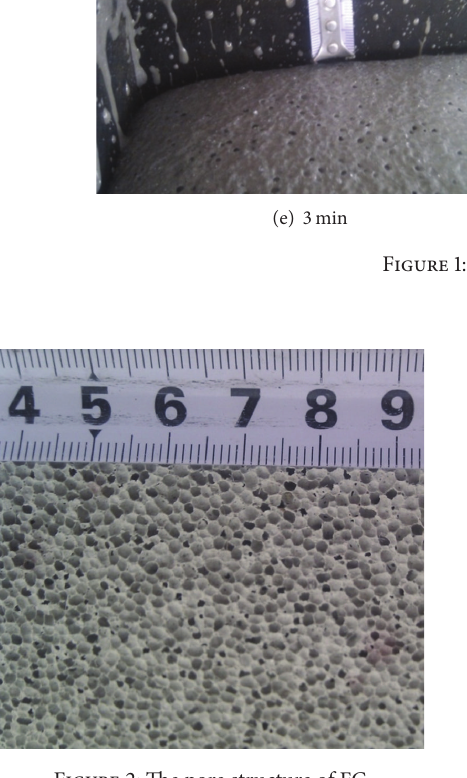
economically activate the fly ash at normal temperature and pressure. Therefore, the mixing amount of self-made fly ash activator is critical to activating the strength of fly